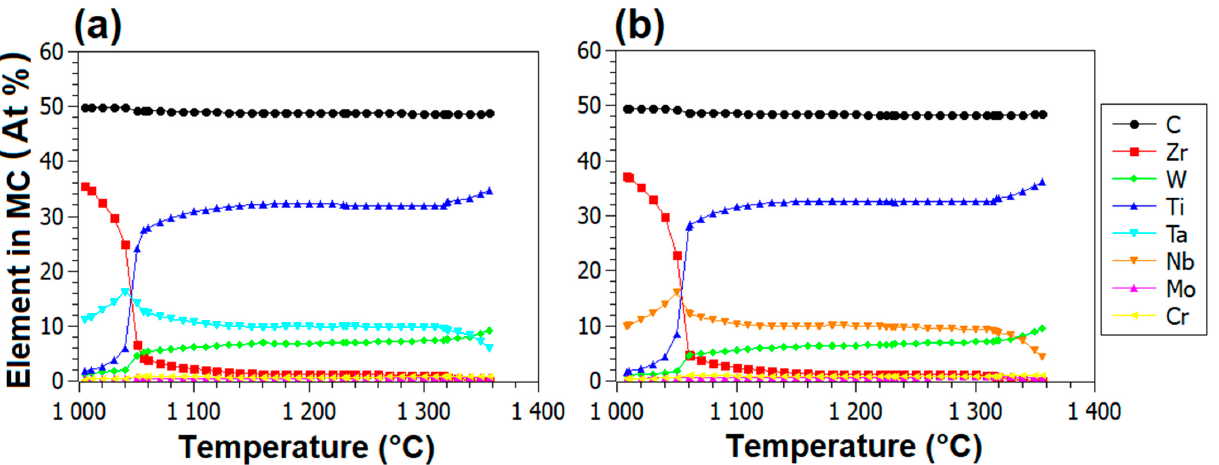
Figure 8. Thermodynamic simulations for carbide composition. ( a ) MAR-M246(Ta), ( b ) MAR- M246(Nb).